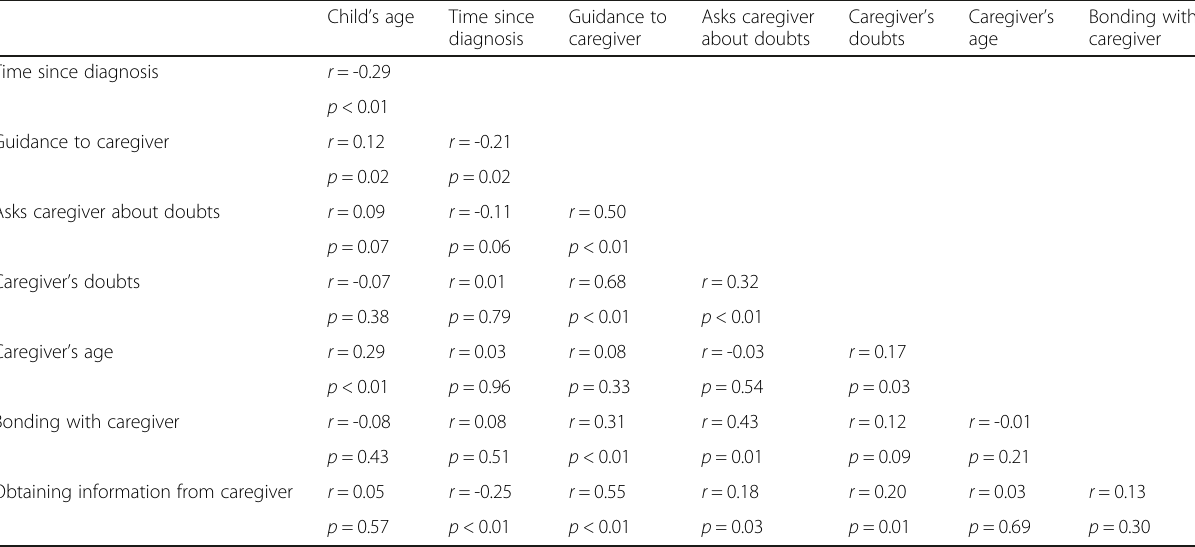
Table 3 Correlations between Sociodemographic and Clinical Dimensions and Pediatrician ’ s Communicative Behaviors towards the Caregiver Child ’ s age Time since